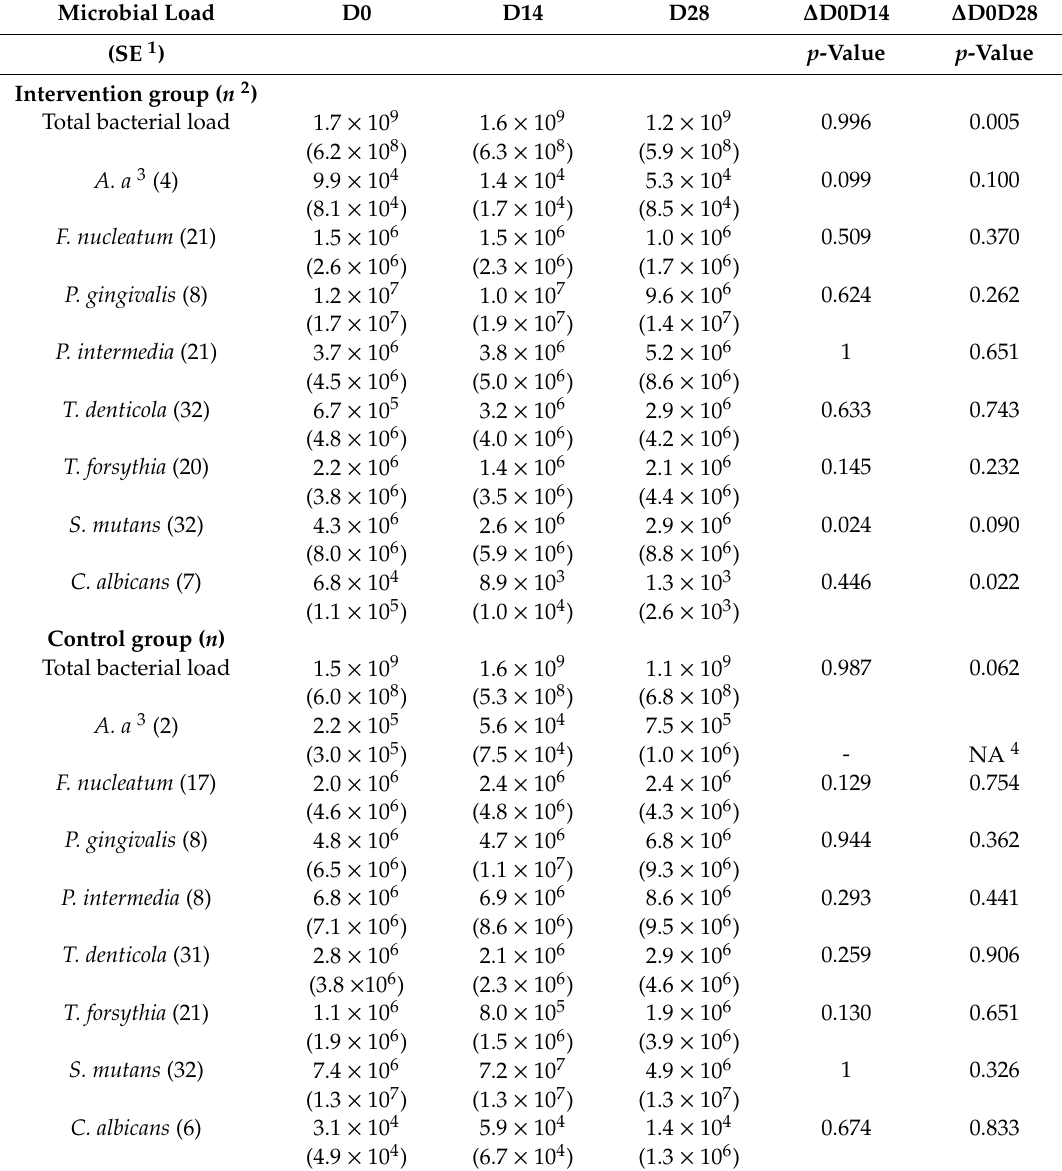
Table 1. Microbial numeration at baseline (D0), D14, and